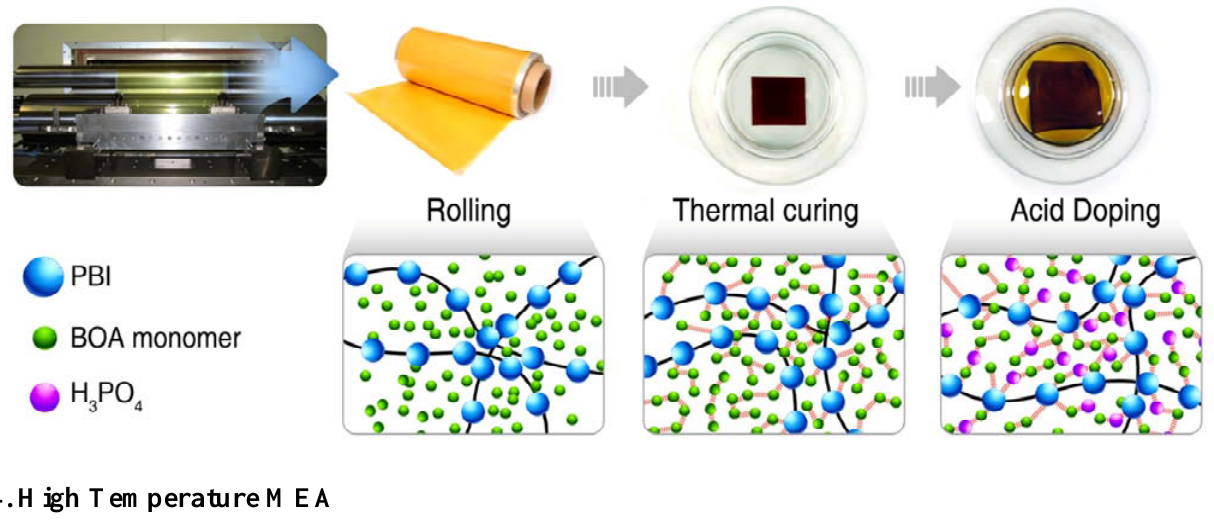
Figure 9. Large-scale (30 cm × 140 m) P( p BUa- co -BI)-65 film using a conventional die coating machine (the picture on top left) and corresponding possible chemical structures (the picture on the bottom in the order of reaction steps) before (left) and after (right) heating at 220 °C and after acid